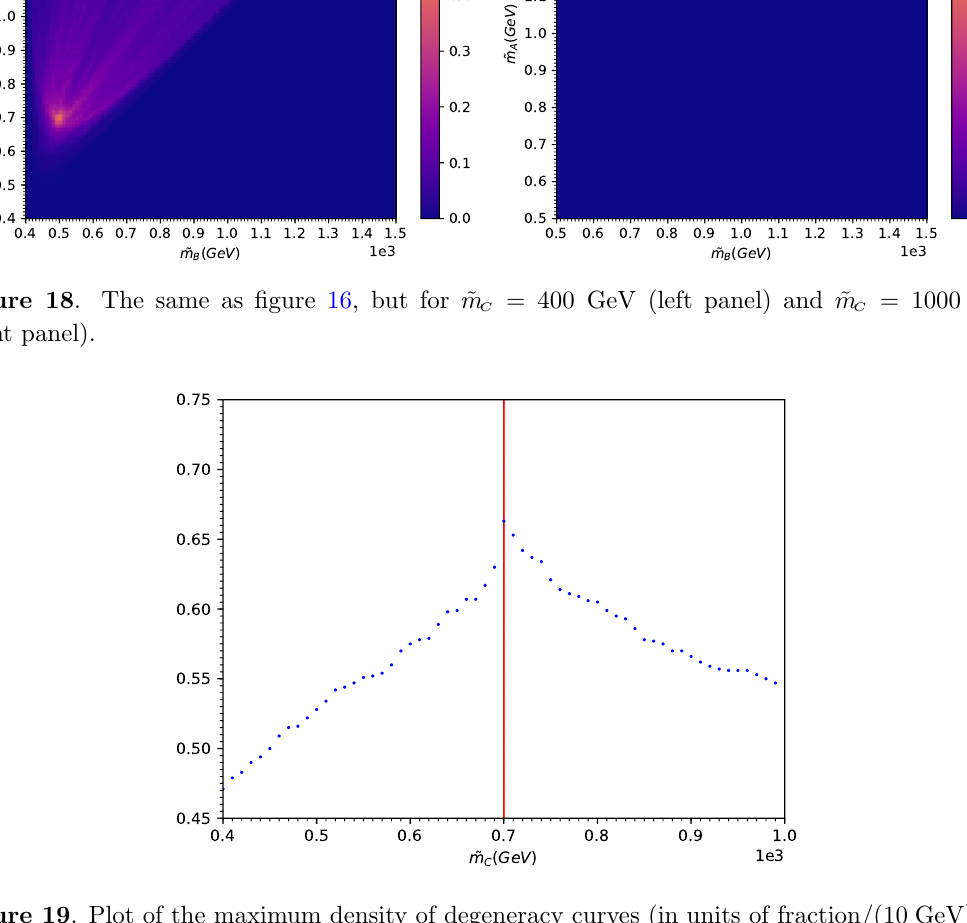
. For each value of ~ m , the maximization is done in the ( ~ m C C = 700 GeV marked with the vertical C